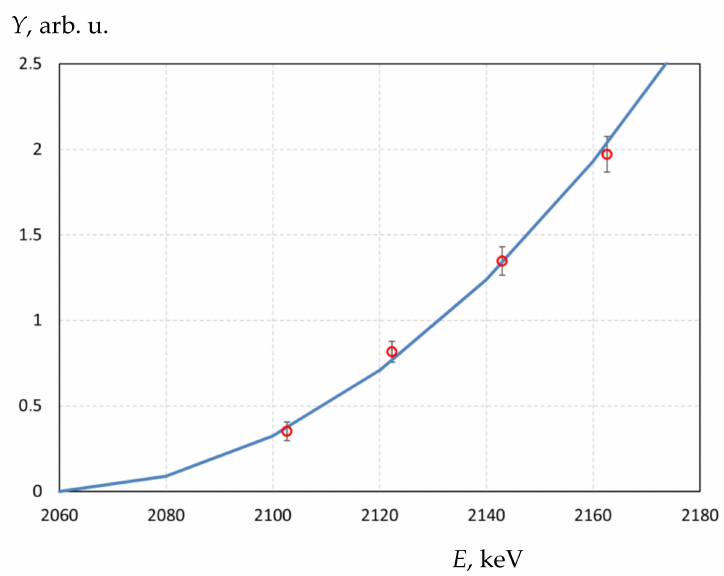
Figure 5. The dependence of the neutron yield Y on the proton energy E in the 9 Be(p,n) 9 B reaction: —measured, solid line—calculated by the PINO program (cid:35)